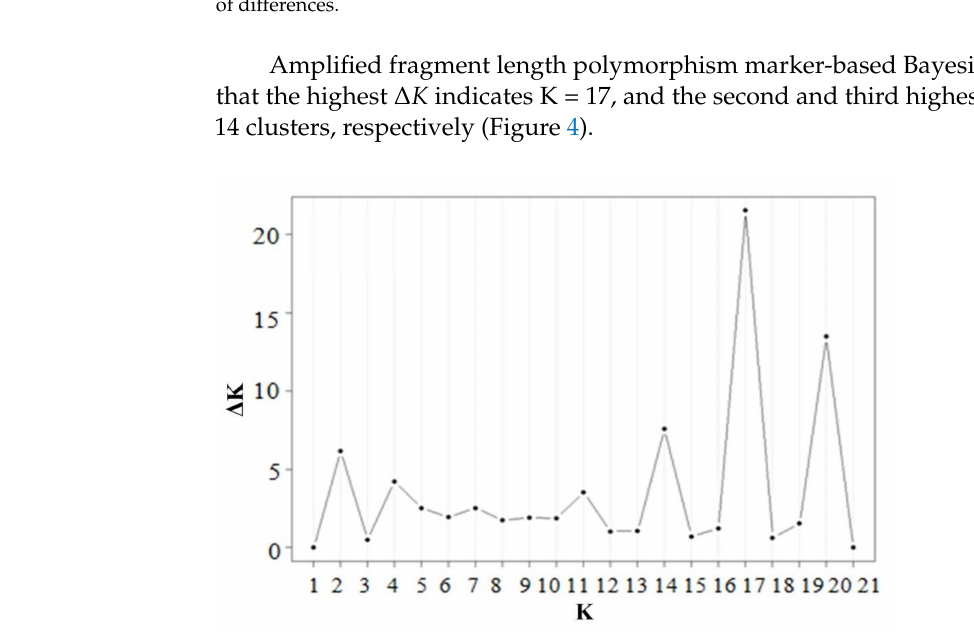
Figure 4. ∆ K statistics for AFLP data-based Bayesian analysis of 21 Lithuanian populations of small balsam ( I. parviflora ). ∆ K values for K ranging between 1 and 21 markers for 21 populations of Impatiens parviflora